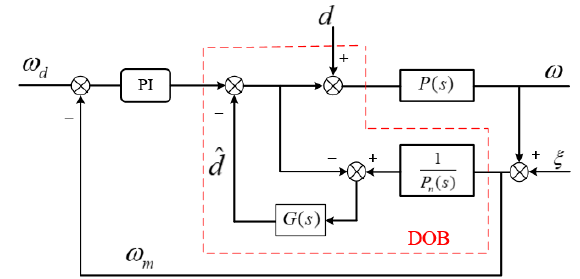
Figure 11. Block diagram of proportional integral (PI) + disturbance observer (DOB).